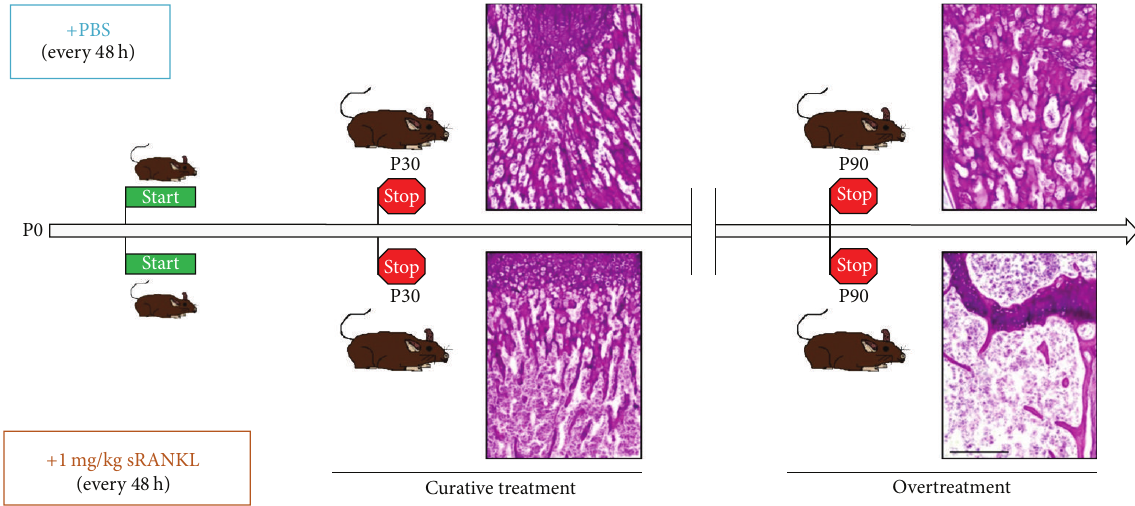
Figure 2: Preclinical studiesin Rankl −/− mice. Rankl −/− micewere injected with either 1mg/kg RANKL (below) or PBS (above) every 48 hours starting within the first week of life. Mice were sacrificed after 1 month (P30) or after 3 months (P90). Periodic acid-Schiff staining (bone in pink, cartilage in violet) of femur sections showed in RANKL-treated mice rescue of the bone defect at P30 and pathological reduction of the bone content at P90, clearly indicating overtreatment. Scale bar: 200 𝜇